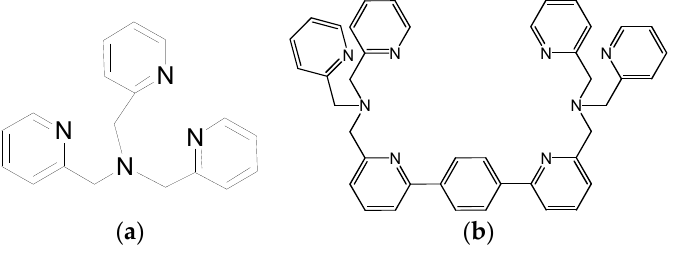
Figure 1. Structures of ( a ) compound 1 , tris(2-pyridylmethyl)amine (TPA) and ( b ) compound 2 , parabenzobis-TPA (PBTPA).